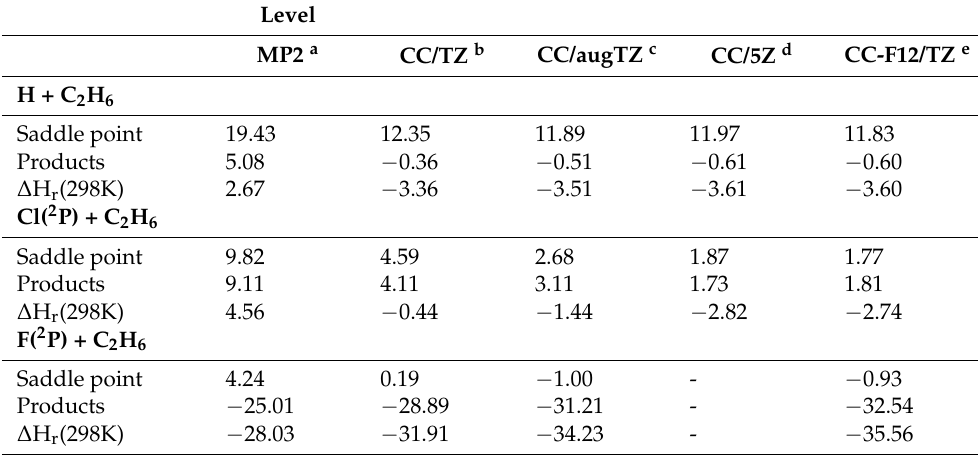
Table 2. Relative energies (with respect to the energy of reactants, in kcal mol − 1 ) of the